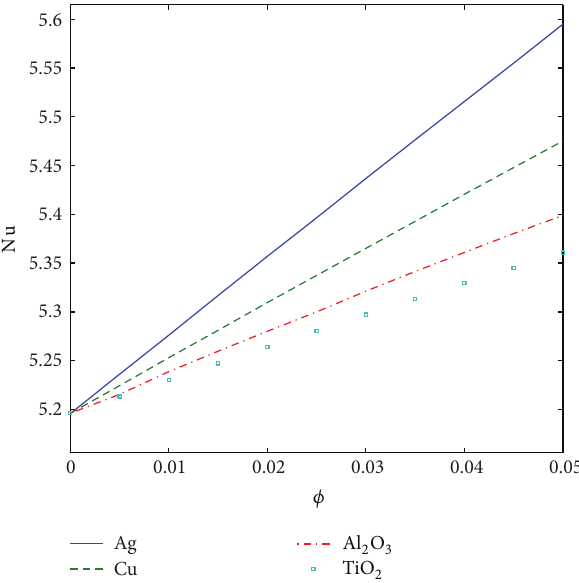
= 4.7 × 10 3 for water-Cu. bf